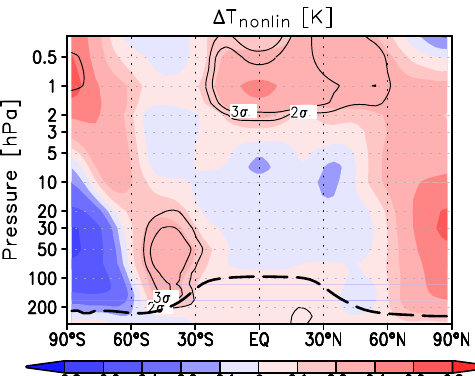
Figure 5. Same as Fig. 2a but for the nonlinear annual mean temper- ature change (K) between 1960 and 2000. The contour lines indicate the regions where the changes are larger than ± 2 σ and ± 3 σ